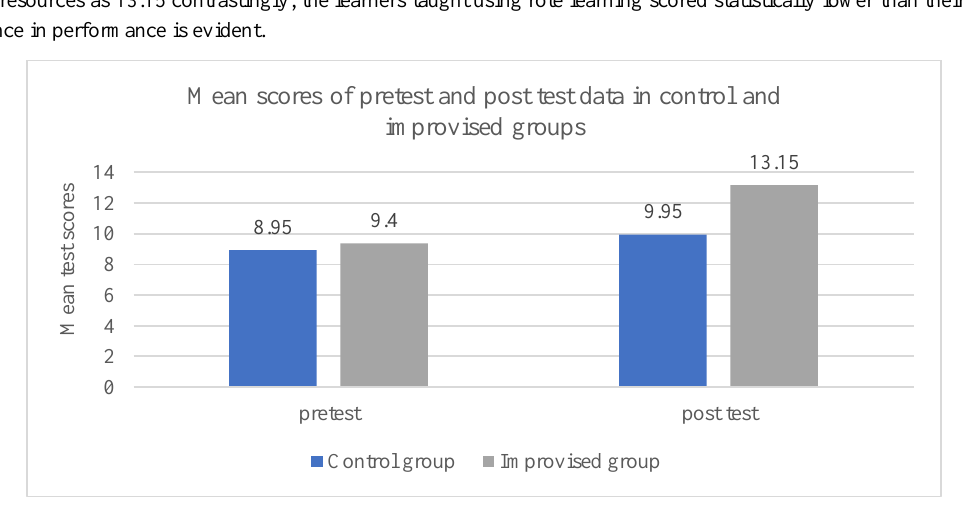
Table 1: Summary Results for The Conventional Group